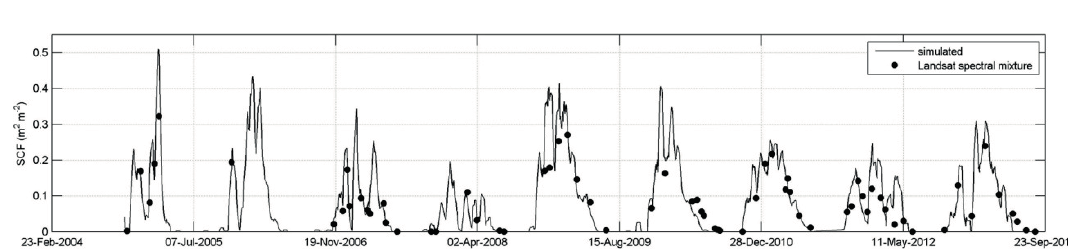
Fig. 3 Evolution of mean SCF over the watershed. Black line represents simulated values and black dots are the estimates from spectral mixture analysis of Landsat imagery.